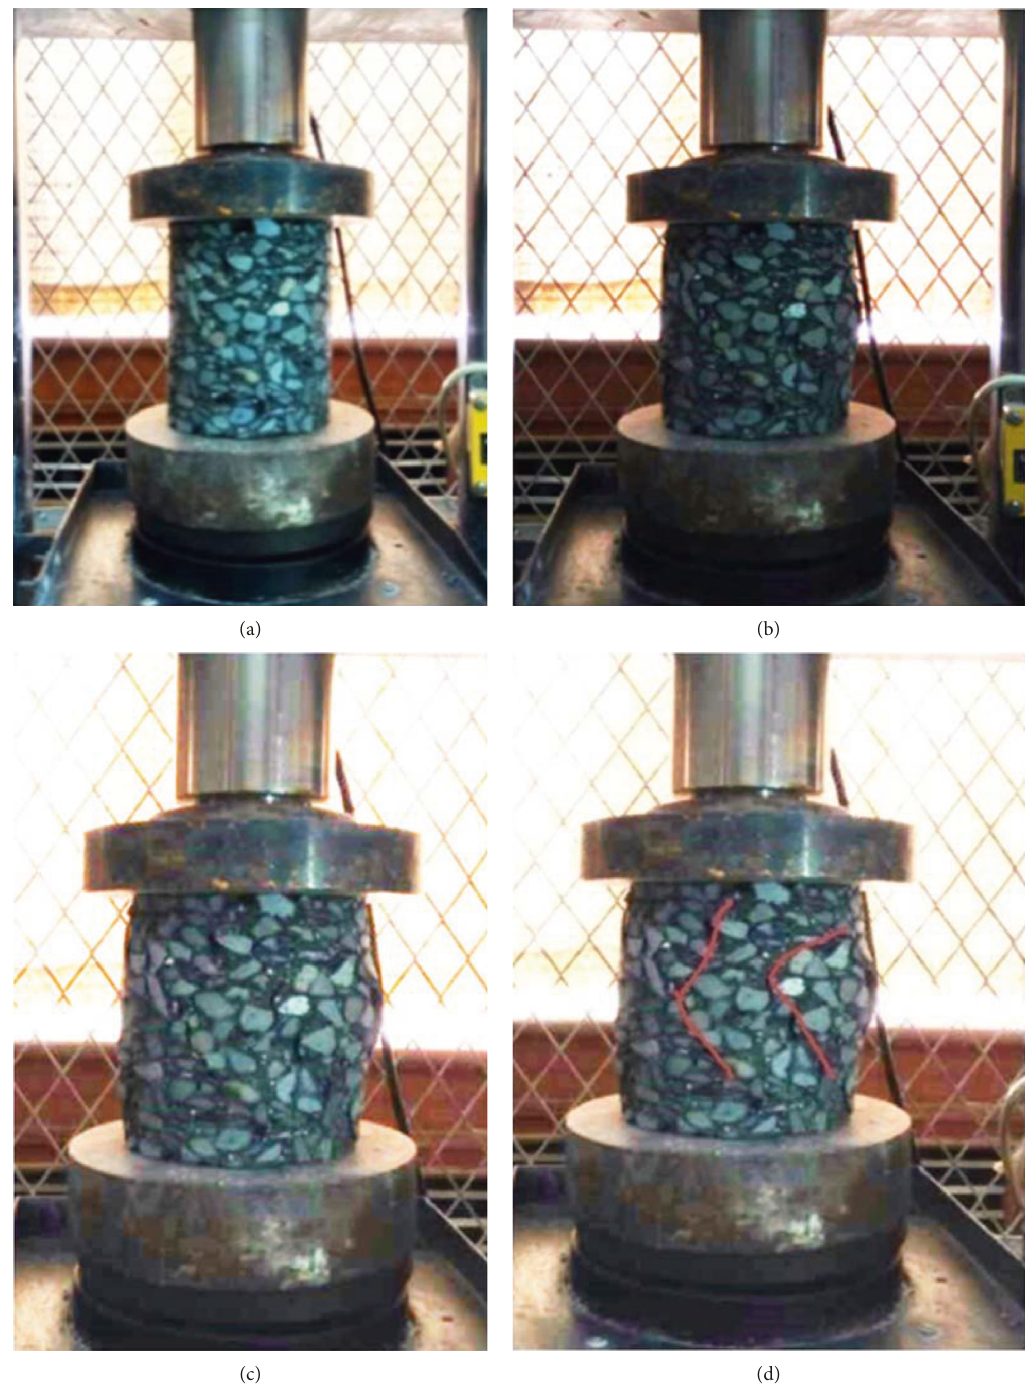
Figure 6: Single-axial compression test of SMA-13 type asphalt mixture: (a) initial compression stage; (b) medium compression stage; (c) final compression phase; (d) terminal compression